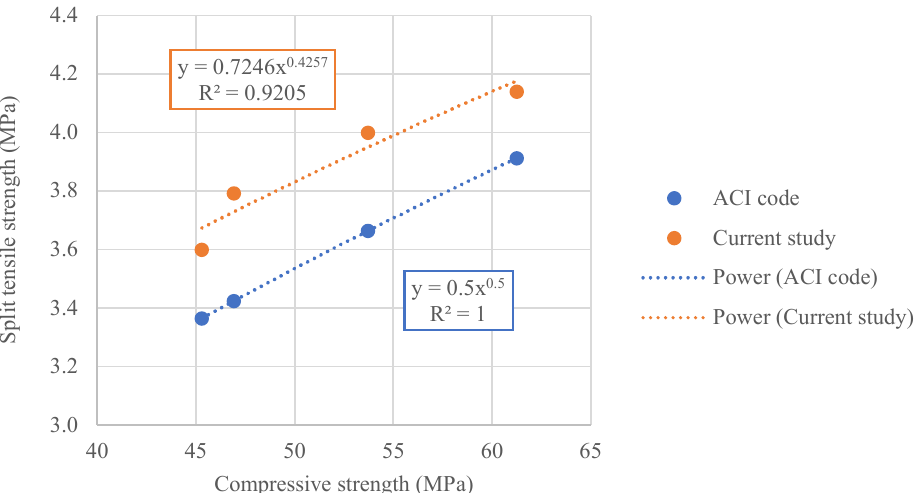
Figure 13. Fitting curve for the split tensile strength compared to ACI code equation.